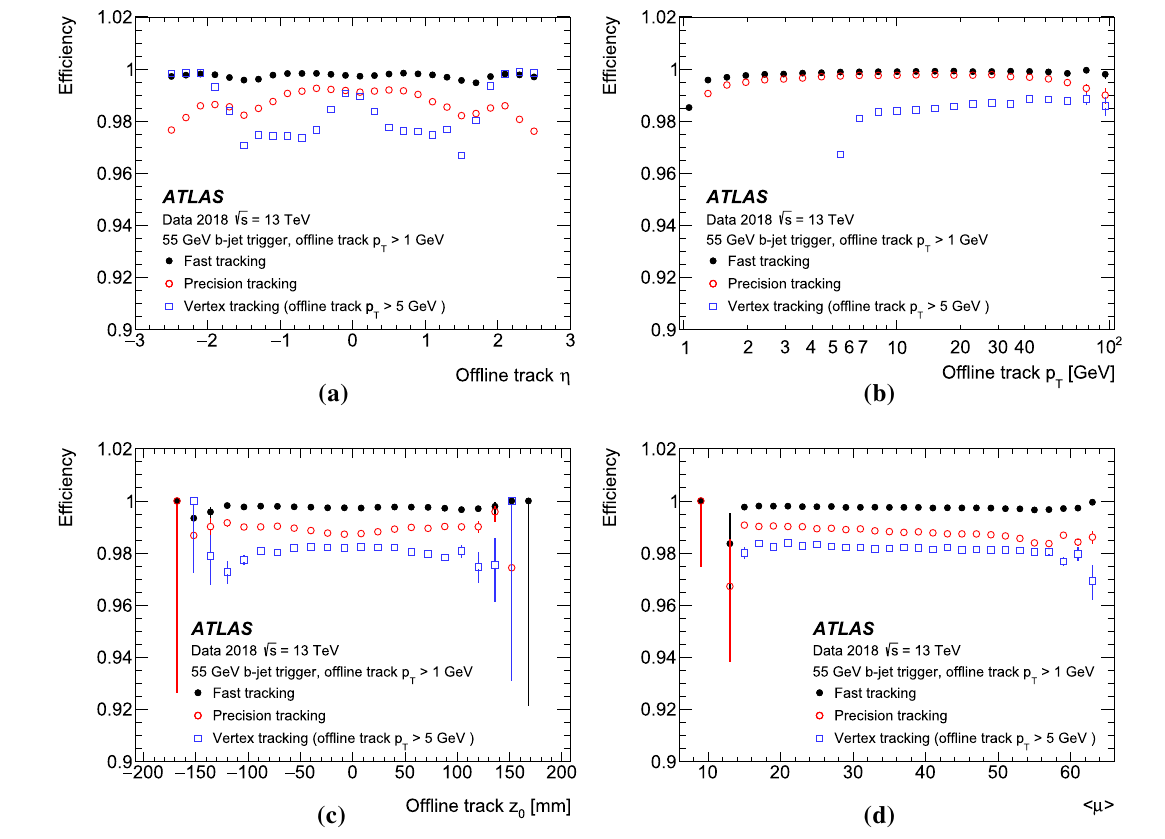
Fig. 35 The performance of the tracking in the b -jet signature, com- paring the RoI based jet tracking with vertex tracking. Shown are the efficiencies with respect to a the pseudorapidity, b transverse momen- tum,and c the z 0 positionatthepointofclosestapproachtothebeamfor